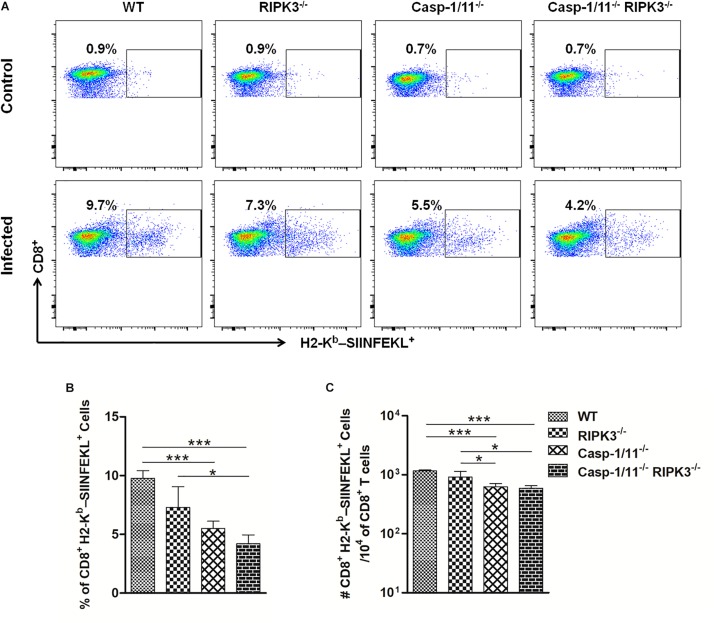
Casp-1/11 deficiency impairs in vivo antigen-specific CD8+ T cell expansion in response to LM-OVA. (A,B) Frequency and (C) total number of OVA257–264 (SIINFEKL)-specific CD8+ T cells in the spleens of infected mice at 7 days after LM-OVA vaccination, revealed by staining with anti-CD8 antibody and H2-Kb-SIINFEKL dextramer. Results are expressed as (A) selected representative image per group or (B,C) representative bar graphic of three independent experiments showing the mean and standard error of five mice per group. Statistical analysis was performed by using two-way ANOVA followed by Bonferroni post-tests. *p < 0.5, ***p < 0.001.